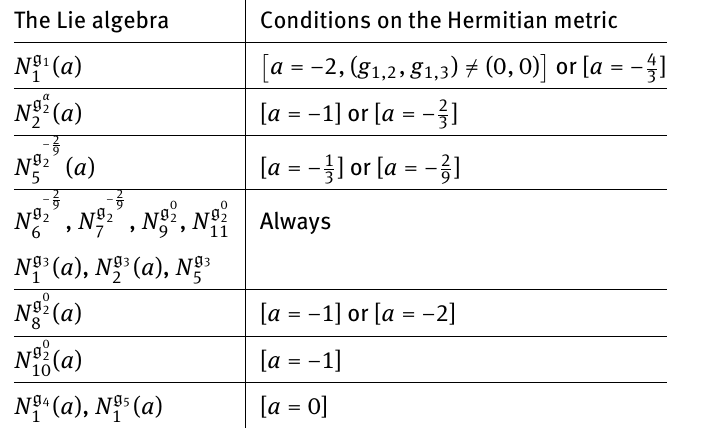
Table 4: Examples of Gauduchon Lie algebras.